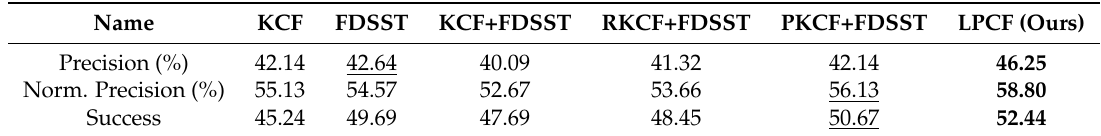
Table 2. Comparison with baseline trackers on the test set of TrackingNet (511 sequences) in terms of precision, normalized precision and success (AUC). The best results and second highest values are highlighted by bold and